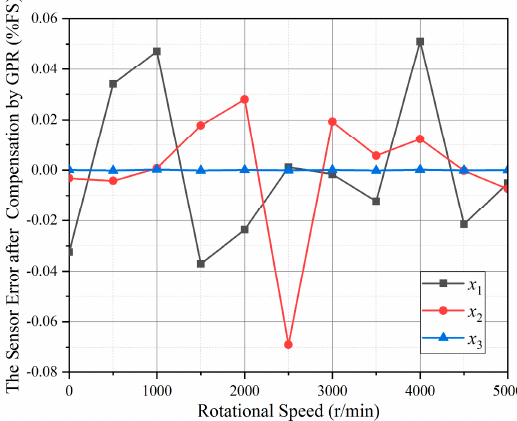
Figure 11. The torque calculation relative error after compensation by Gaussian processes regression (GPR).